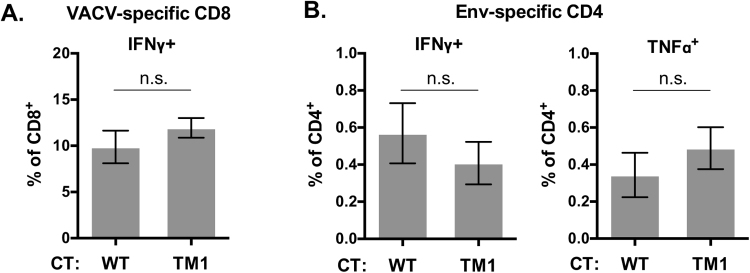
No significant difference in VACV-specific CD8+or Env-specific CD4+T cell responses resulting from TM1 CT modification. Splenocytes from mice immunized with 89.6 N7 Envs with WT or TM1 CT were stimulated with peptide pools from (A) VACV or (B) SHIV 89.6P Env and were stained for intracellular cytokine expression. Data represent mean frequencies of IFNγ+ and TNFα+ cells, as a percentage of total CD8+ or CD4+ T cells, and error bars are the SEM; n.s. = not significant (p > 0.05) by Mann-Whitney test.